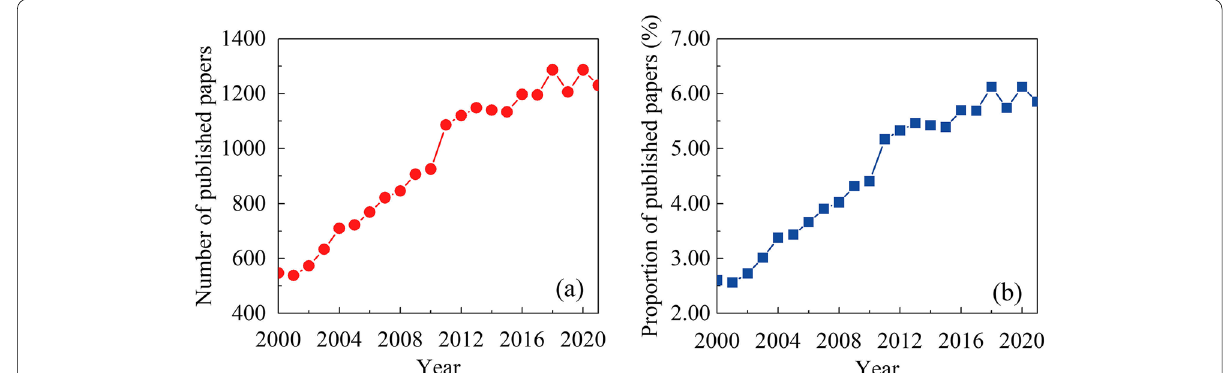
Fig. 2 Publishing trend in axonal regeneration. The chronological distribution of the number ( a ) and proportion of published articles ( b ) related to axon